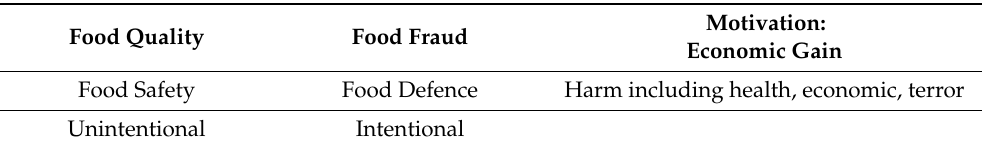
Table 2. The food risk matrix distinguishes between food quality, food safety, food fraud, and food defense. Source: